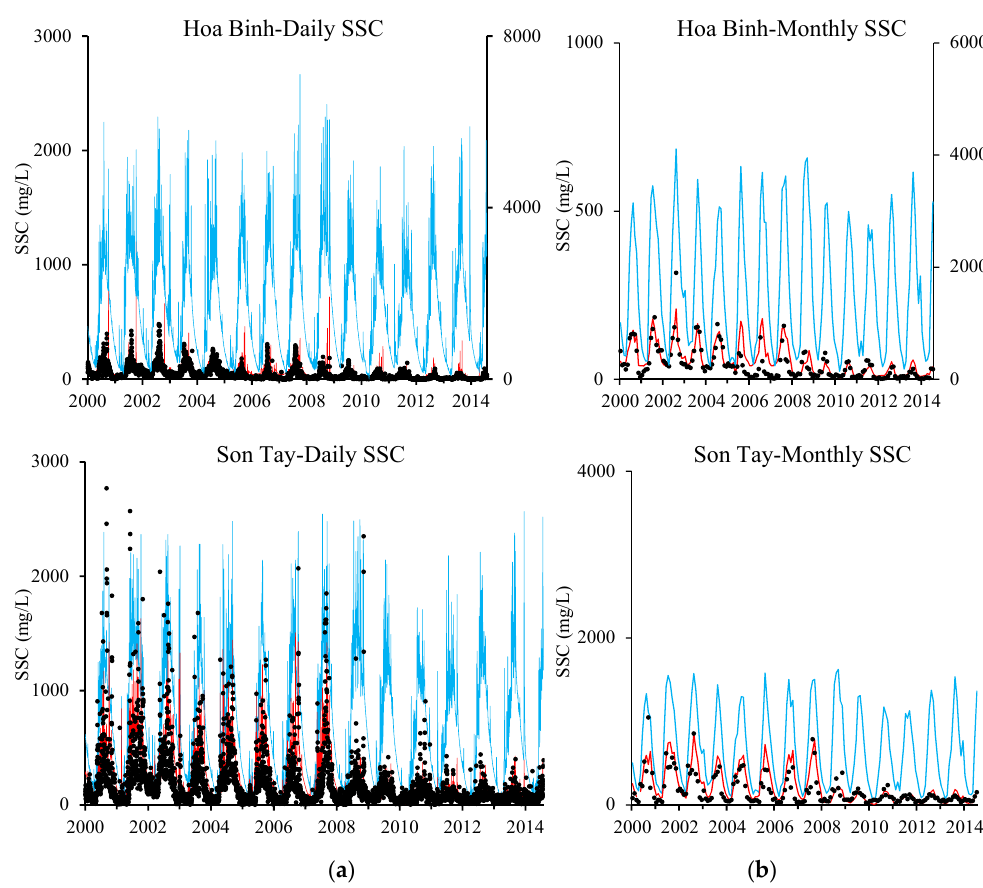
Figure 4. Observed (black dot) and actual simulated (red solid line) daily ( a ) and monthly ( b ) suspended sediment concentration (SSC) at five stations from January 2000 to July 2014. Blue solid line represents the scenario simulation of SSC under natural conditions.